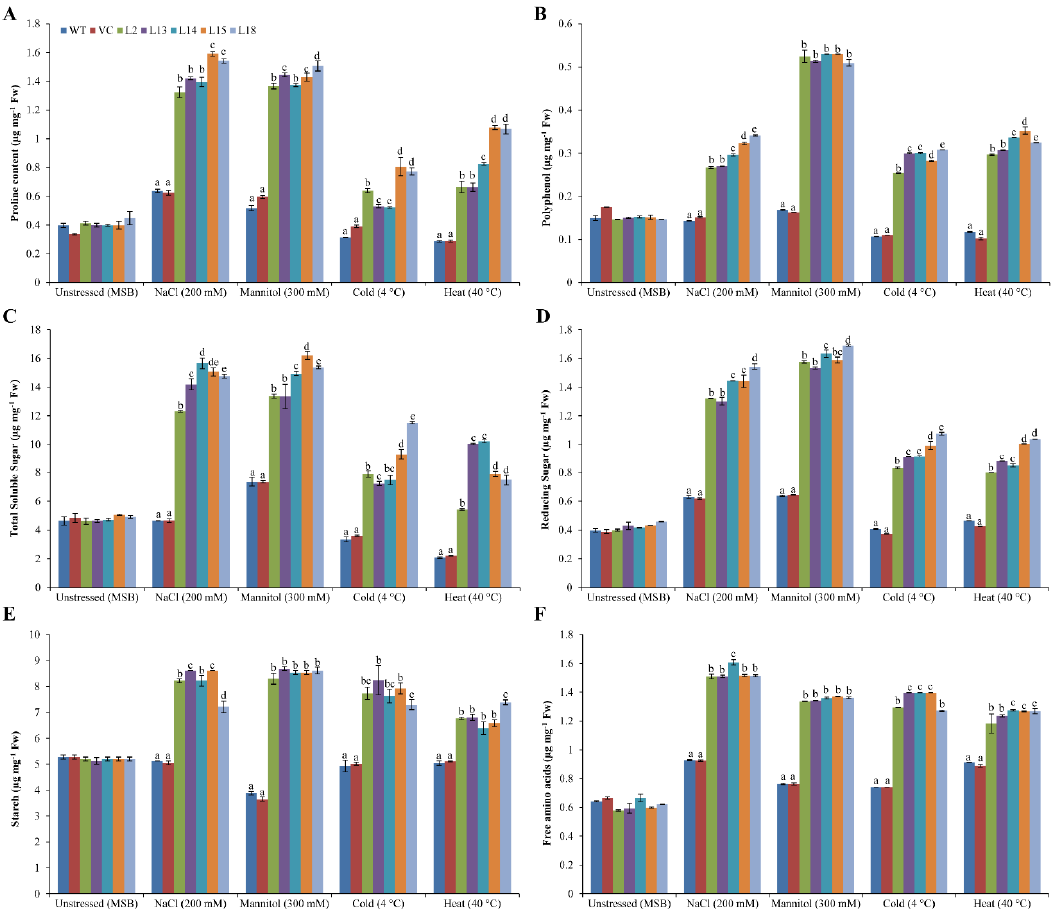
Figure 5. Quantification of osmoprotectant contents under diverse abiotic stress conditions. Com- parative analyses of ( A ) proline, ( B ) polyphenol, ( C ) total soluble sugar (TSS), ( D ) reducing sugar (RS), ( E ) starch, and ( F ) free amino acid (FAA) contents of transgenic (L2, L13, L14, L15, and L18) and control plants (WT and CV) grown under unstressed (MSB), salt (200 mM NaCl), osmotic (300 mM mannitol), cold (4 ◦ C), and heat (40 ◦ C) stress conditions. Data are shown as mean ± SE and different letters show significance at p <